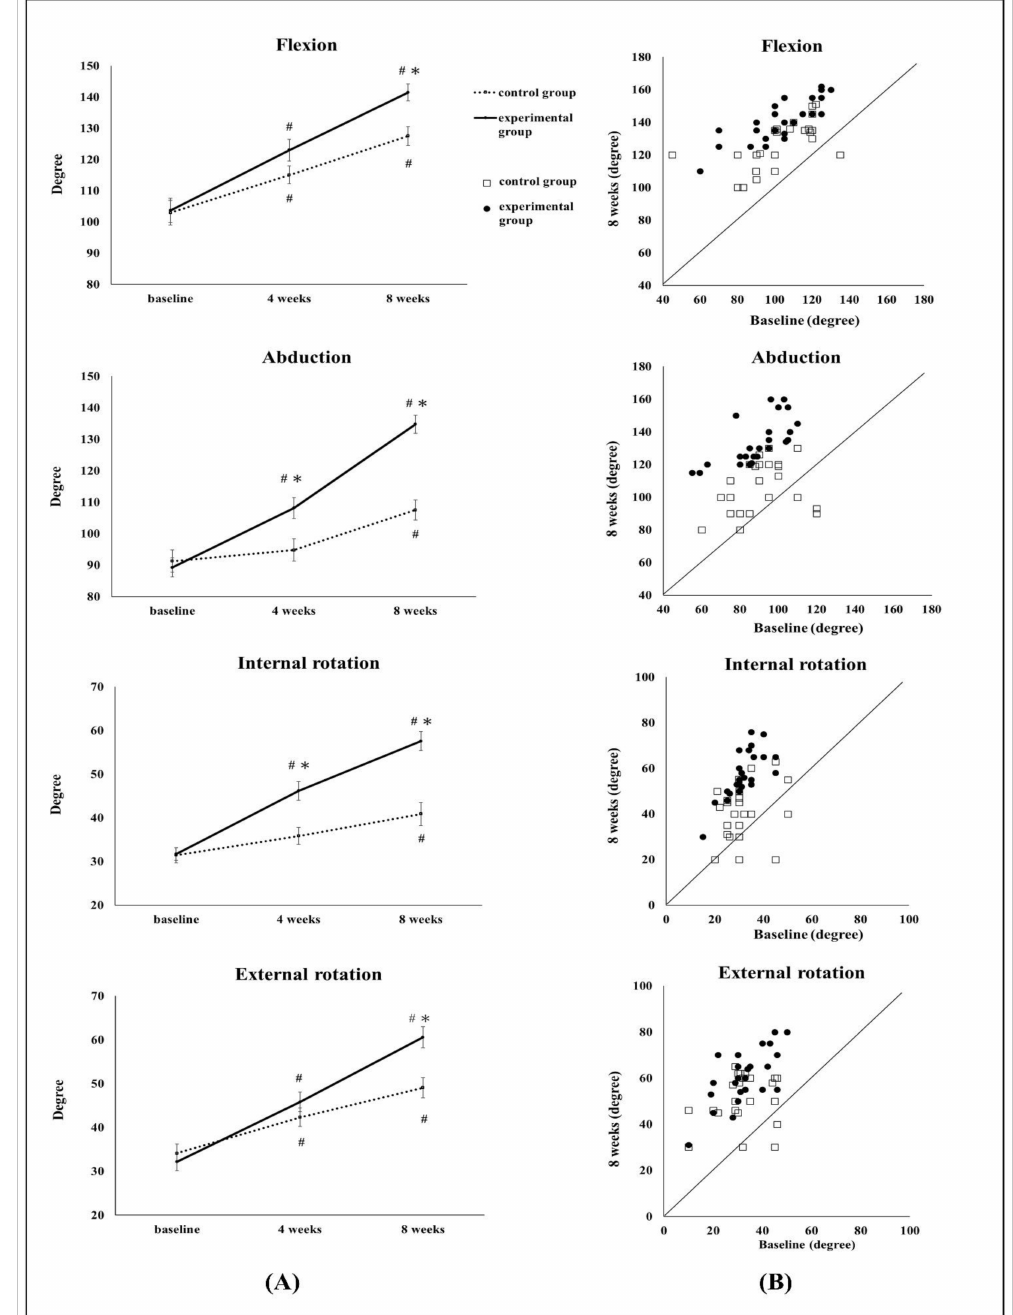
Figure 3. Shoulder range of motion (ROM) at the baseline, four weeks, and eight weeks between the control group and experimental group ( n = 24 per group). ( A ) The dashed line indicates the trend of shoulder ROM of the control group (CG) and the solid line indicates that of the experimental group (EG) (mean ± SE). #: significant difference when compared to the baseline within the group ( p < 0.05). *: significant difference between the experimental group (EG) versus control group (CG) ( p < 0.05). ( B ) The identity plot presents the distribution of the individual shoulder ROM of the control group (CG: empty square) and experimental group (EG: solid circle) at eight weeks of treatment. The identity line indicates no change of shoulder ROM after eight weeks of treatment; the upper half of the identity line means improvement; the lower half of the identity line means the condition